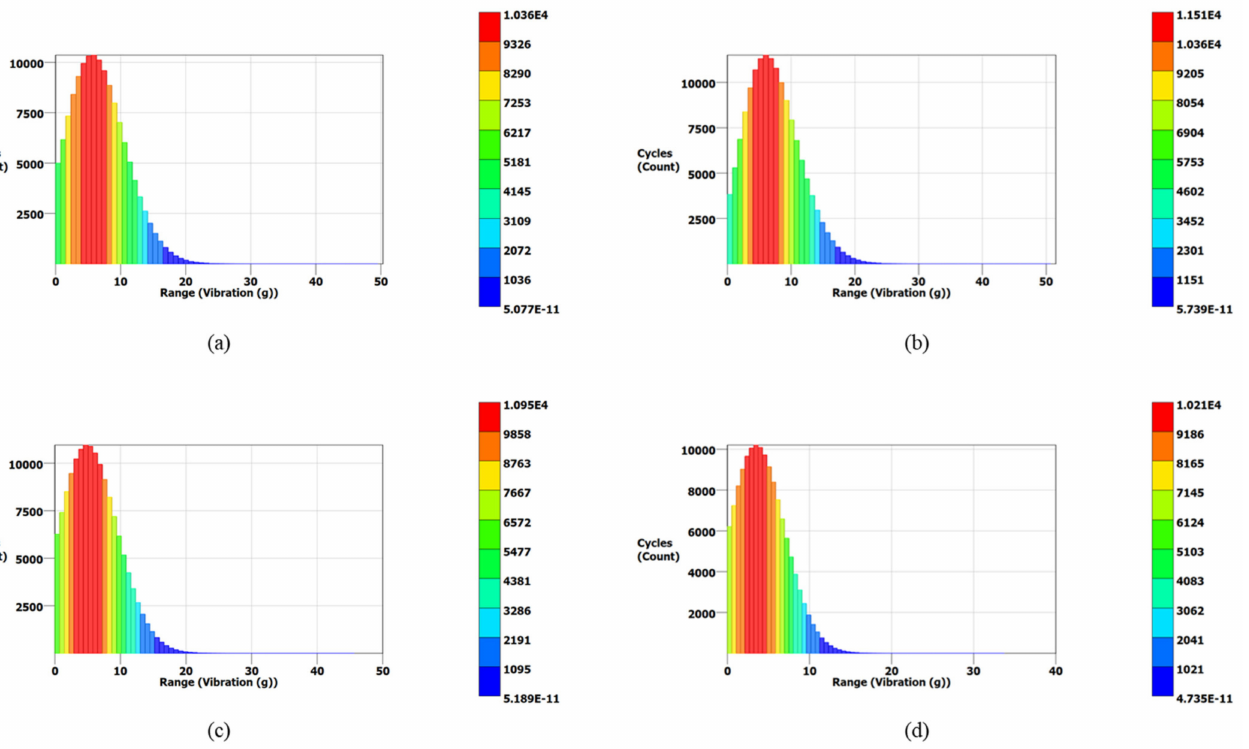
Figure 15. PDF results for turbine blades using the Lalanne approach: ( a ) the solid blade; ( b ) the 0.75 mm lattice blade; ( c ) the 0.50 mm lattice blade; ( d ) the 0.25 mm lattice